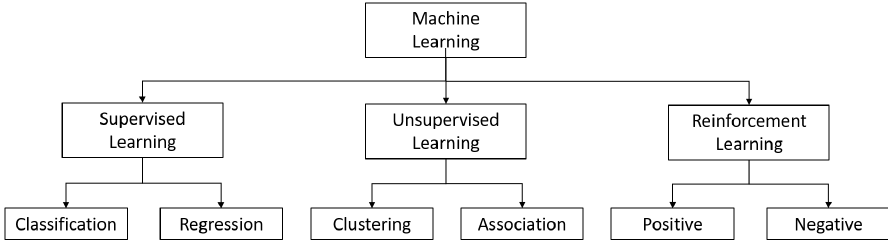
Figure 2. Machine